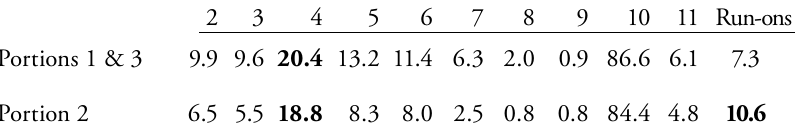
Table 2 – Arden of Faversham : Strong Syntactic Breaks After Positions 2, 3, 4-11. Run-on